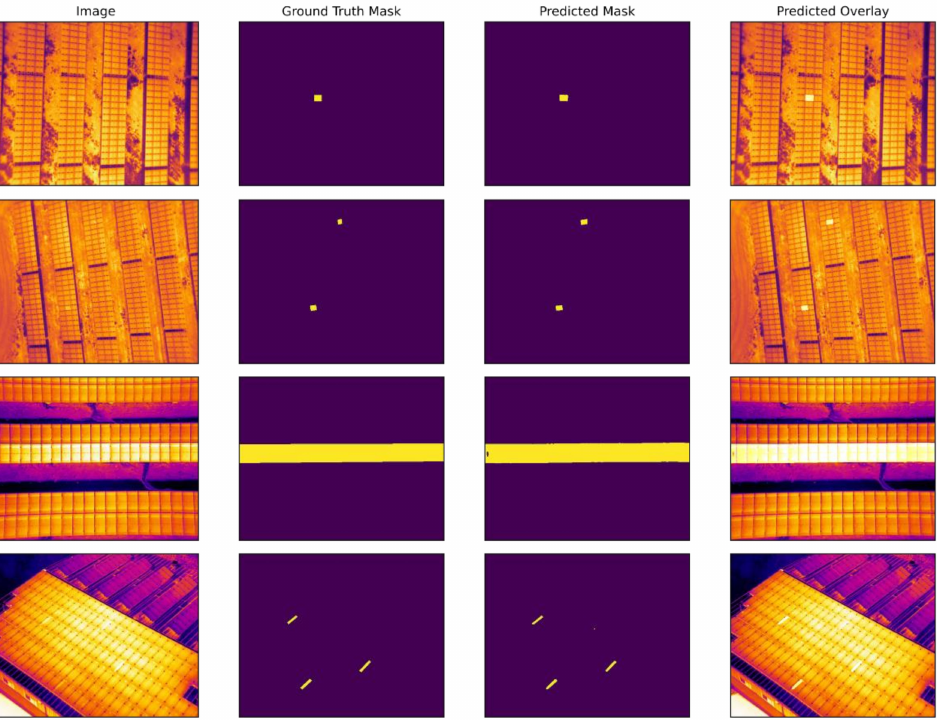
Figure 11. Original, ground-truth mask, model-predicted mask and predicted overlay images of PV plant fault detection experiment using U-Net segmentation